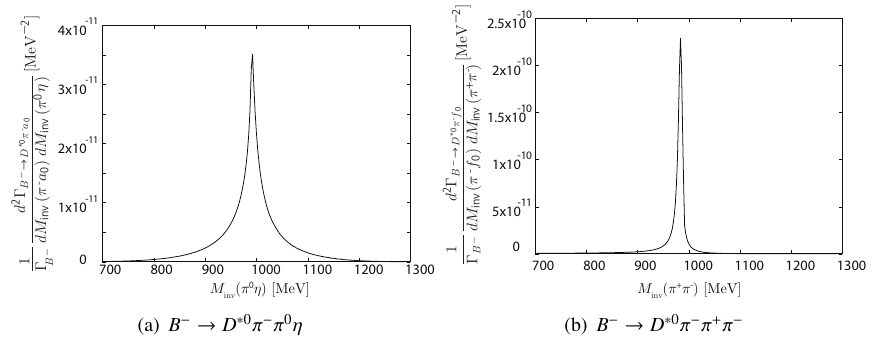
Figure 1: The derivative of the mass distribution with regards to M inv ( R ).